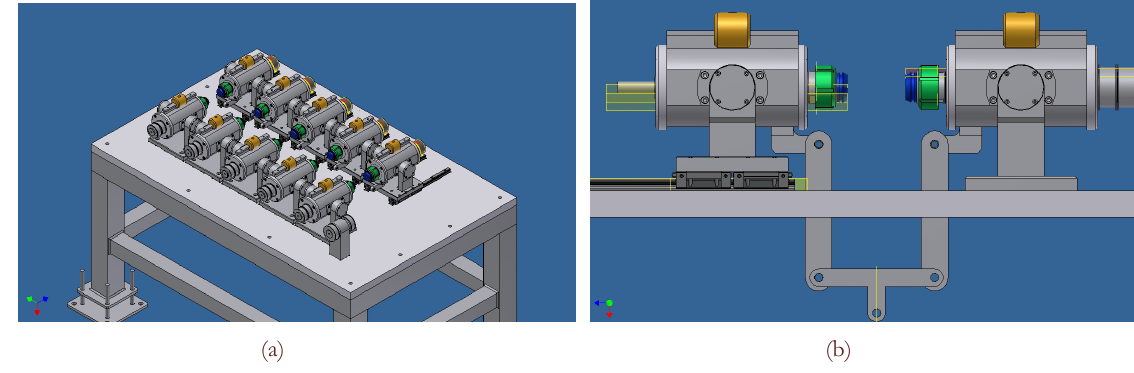
Figure 5: Spindles group: a) total view; b) load system details.